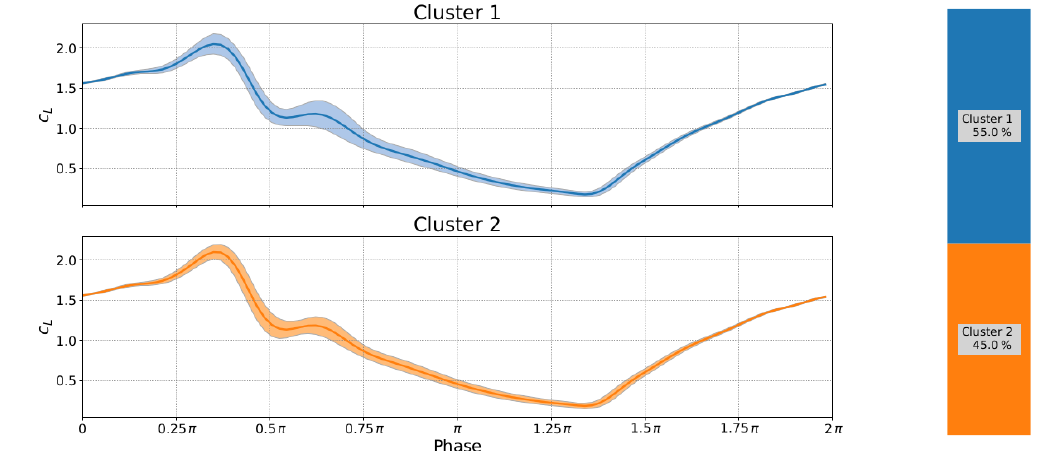
Figure 18. Deep stall investigations: cluster analysis for boundary conditions: k = 0 . 1346, Re = 3 × 10 5 and α 0 = 18 ◦ , α amp = 7 ◦ .